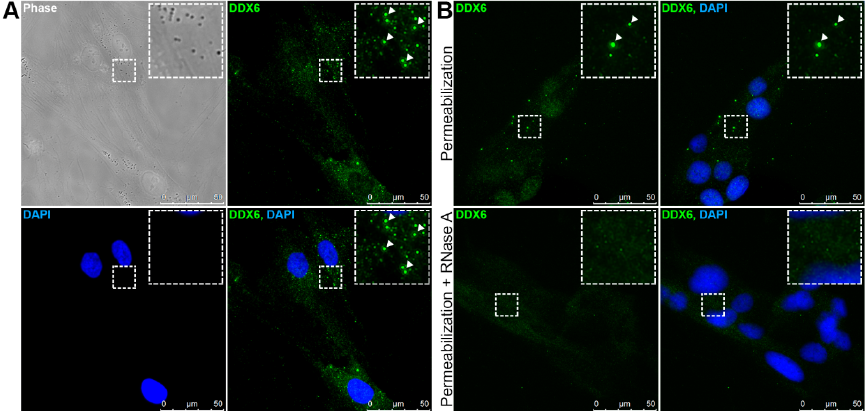
Figure 1. Human adipose tissue-derived stem cells (hASCs) have RNA-dependent DDX6 granules. ( A ) Results from the immunofluorescence analysis of DDX6 localization in the hASCs. The helicase is dispersed in the cell cytoplasm and accumulates in granules. ( B ) Results from the immunofluorescence analysis of DDX6 in permeabilized or permeabilized and RNase A-treated hASCs. After RNase action, the DDX6 granules were disassembled. White arrows: granules that contain DDX6. Nuclei were stained with